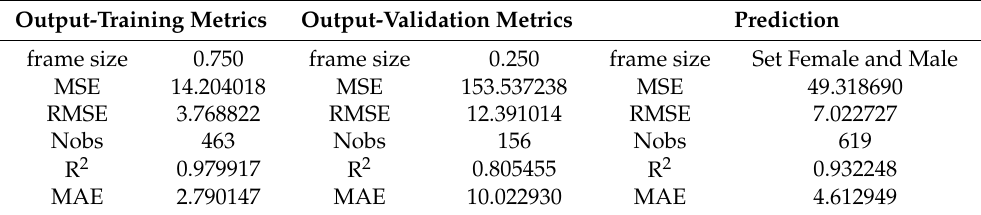
Table 1. Parameters of the generated model—age assessment for men and